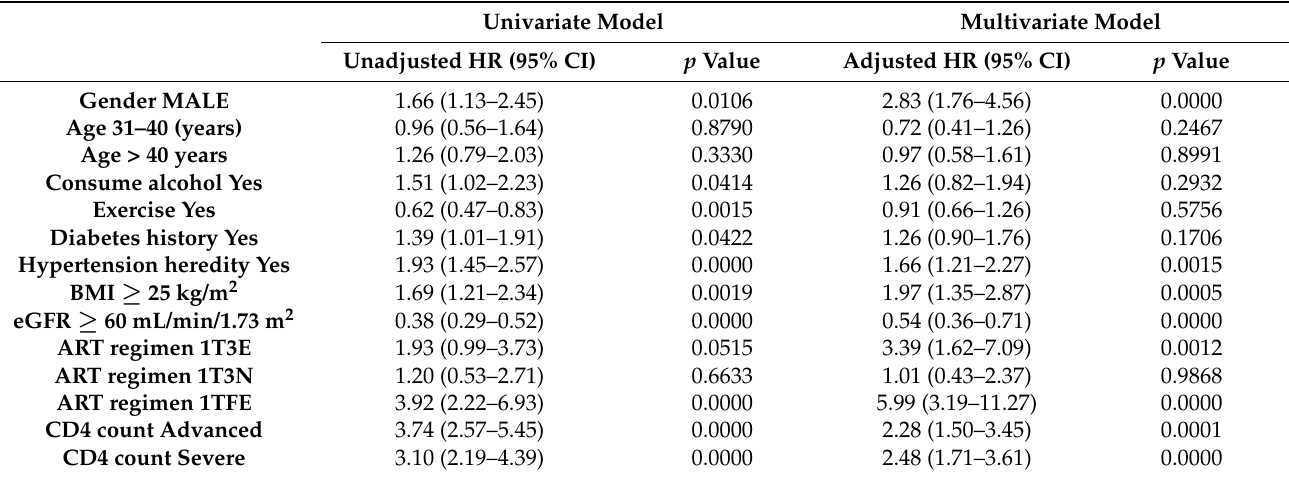
Table 2. Cox regression analysis of risk factors of